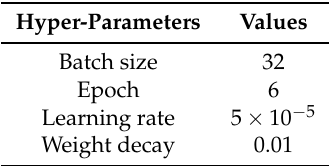
Table 4. Hyper-parameters.